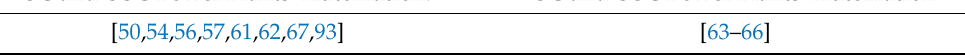
Table 2. Control configuration summary (coverage 1978-2020). Parallel Scheme of Multivariable Control for SC and USC Power Plants’